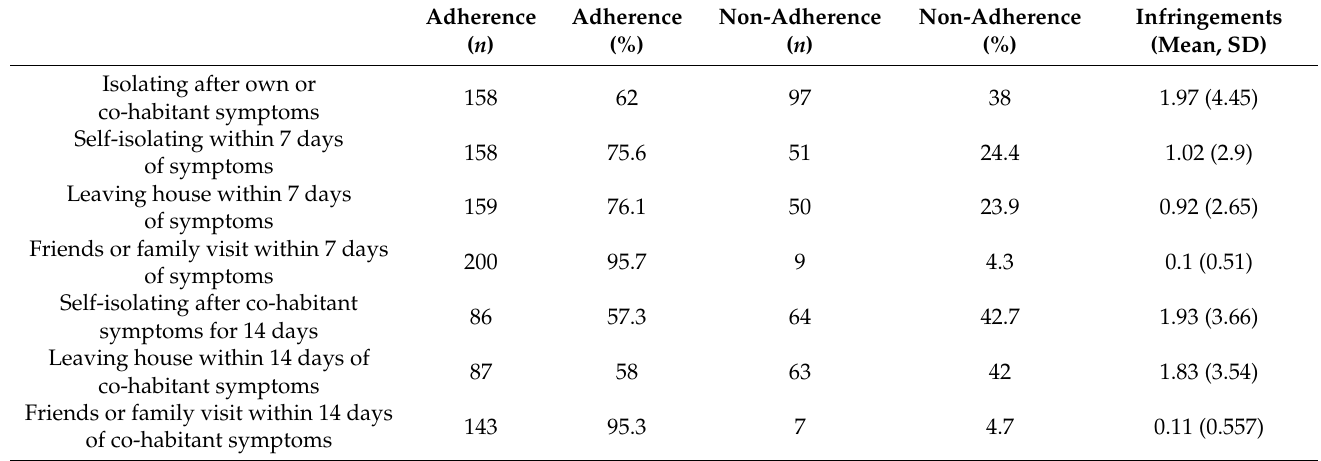
Table 3. Non-adherence of SI and quarantine rules.